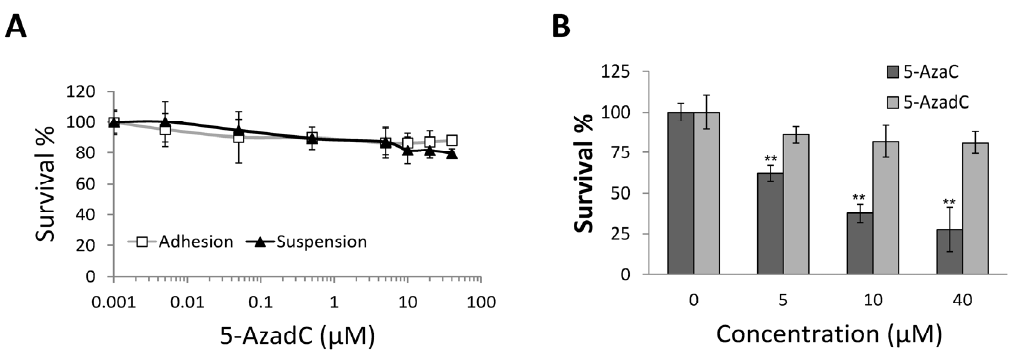
Figure 4. ( A ) 5-Azadeoxycytidine was not cytotoxic to either adhesion or suspension MCF-7 cells. ( B ) Comparison of the effects of 5-AzaC and 5-AzadC on the 48 h survival of suspension MCF-7 cells. Mean ± SD, n = 3; ** p < 0.01 between cells treated with 5-AzaC or 5-AzadC.